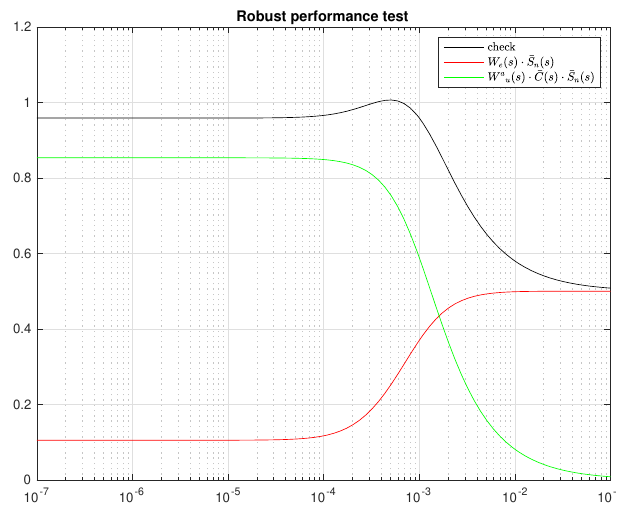
Figure 16. Formal robust performance analysis for the reduced order controller, ¯ C ( s )